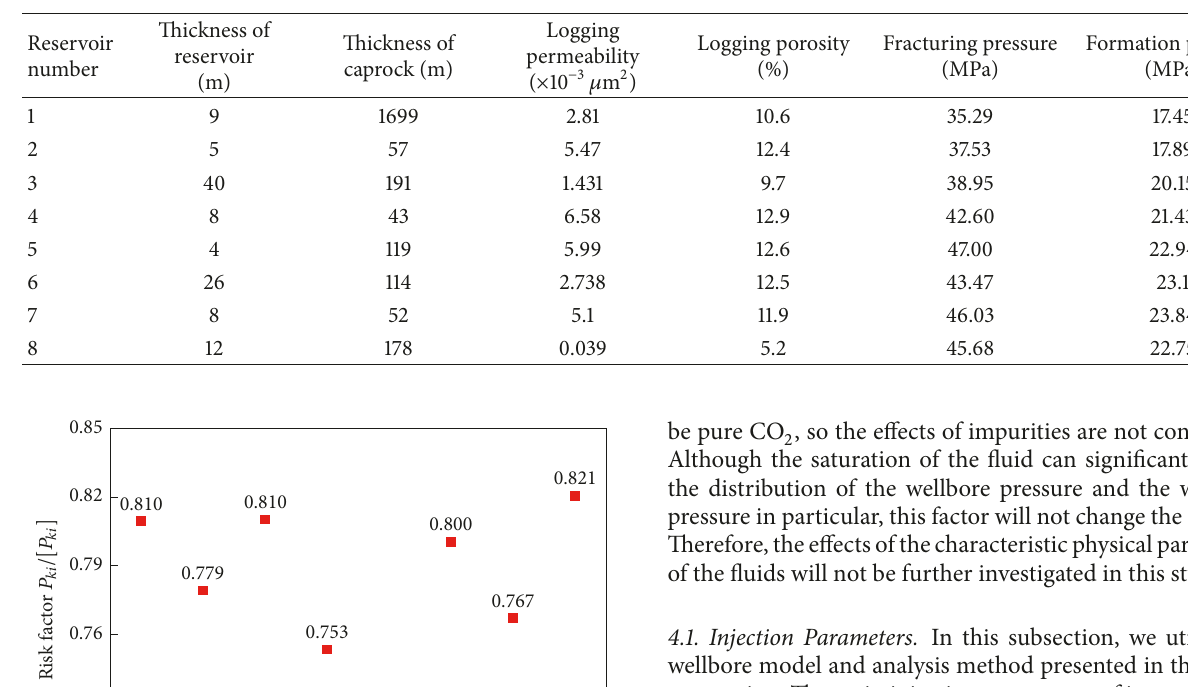
Table 1: Parameters of the reservoir-caprock units of the Shenhua CCS project.